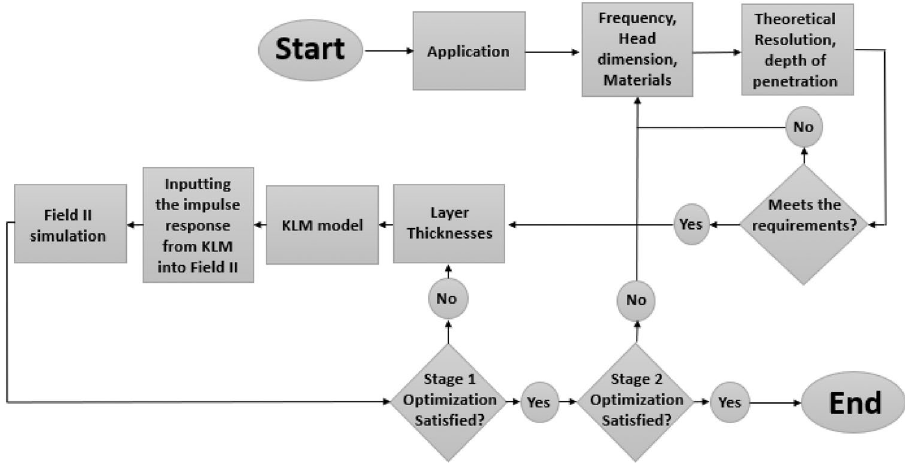
Fig. 2 Flowchart of the optimal design